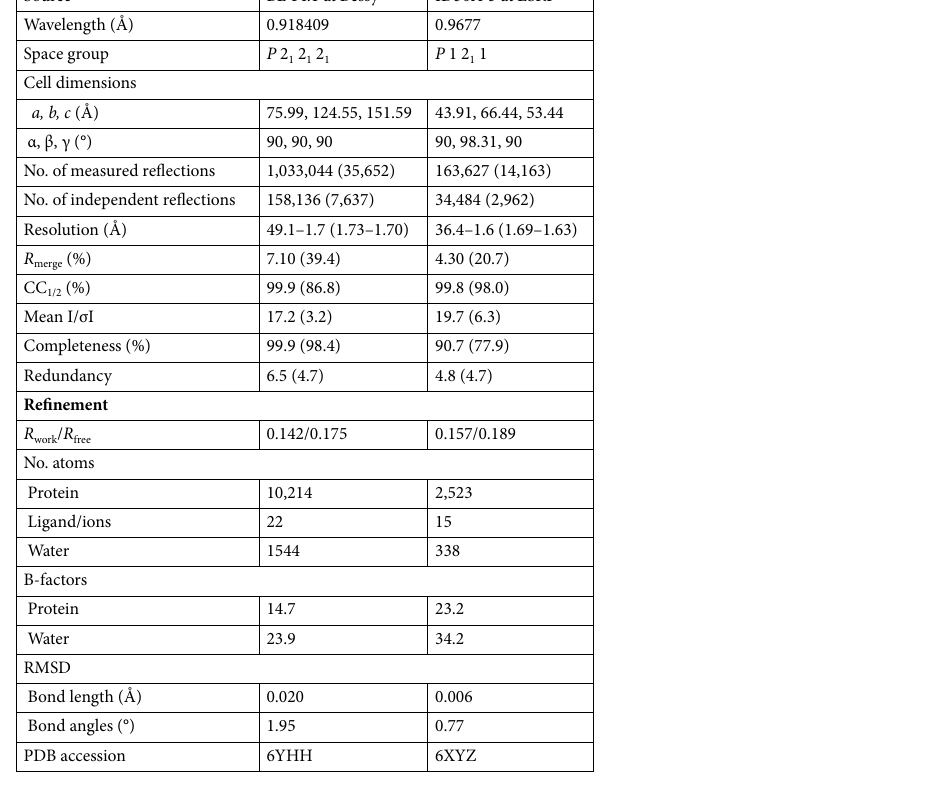
Table 2. Summary of crystallographic